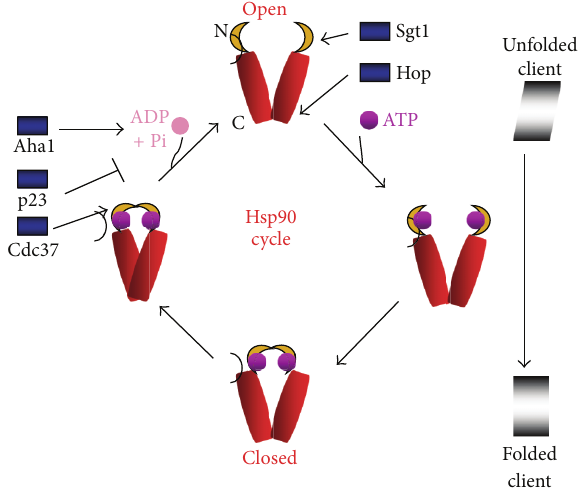
Figure 2: Reaction Cycle for Hsp90. Hsp90 functions as a dimer in a cycle of client binding, ATP binding, ATPase activity, and nucleotide exchange as with Hsp70. The dimers are in an open conformation when empty and a more closed conformation when ATP binds. Substrate binding is assisted by co-chaperone Sgt1. For Hsp90, in which prolonged “holding” of clients seems an important component of its cellular function, the co-chaperones p23 and Cdc37 inhibit ATPase activity and stabilize Hsp90 client complexes. For nucleotide exchange to take place after ATPase activity eventually occurs, Aha1 functions as an exchange factor. As with Hsp70, triage of the protein between pathways of protein quality control involves scaffold protein Hop that binds the C- terminal TPR domain-binding motif (TBD). Through the TBP, Hsp90 can interact with a range of TPR domain containing co- chaperones that regulate intracellular